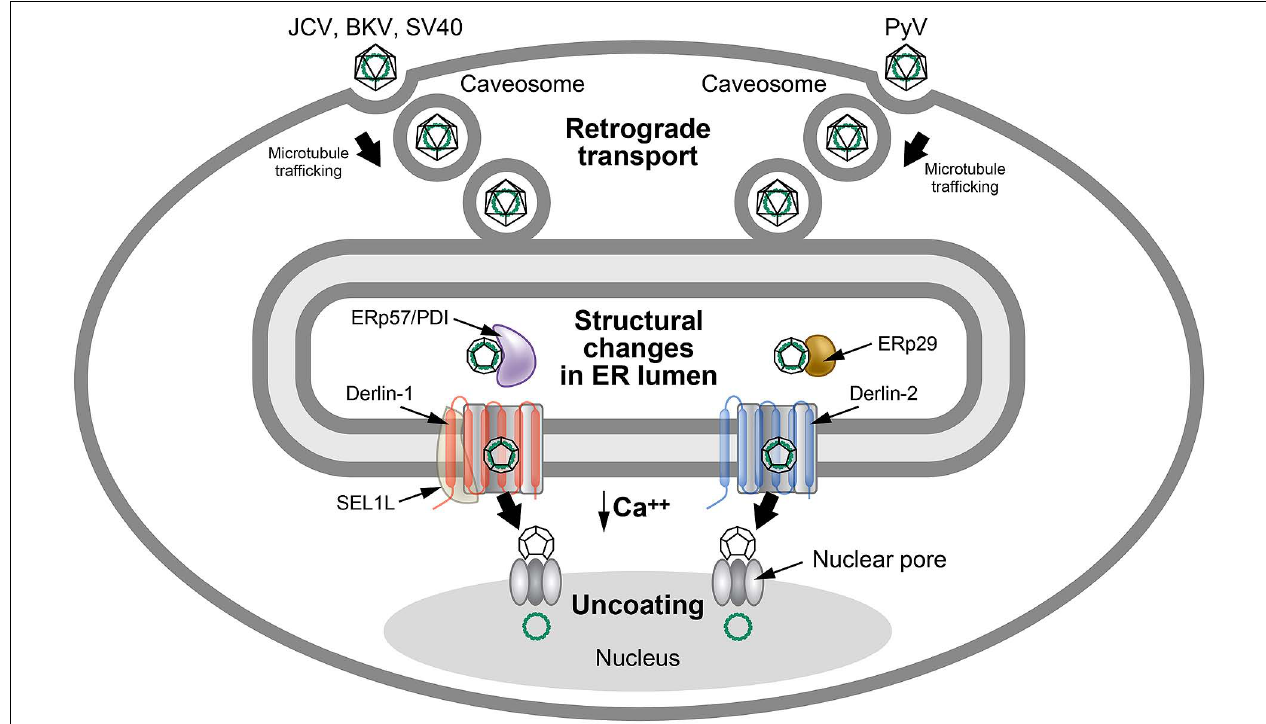
FIGURE 5 | Use of ERAD for polyomavirus uncoating. Many polyomaviruses enter through caveosomes that are enriched for viral entry receptors, triggering particle uptake through endosomes. Using the microtubule network, vesicles traffic the virus to the ER, where the unique environment allows structural changes to the icosahedral capsids. Studies of JCV, BKV, and SV40 indicate that viral particles interact with PDI and ERp57 in the ER lumen to rearrange capsid proteins. In contrast, the related mouse